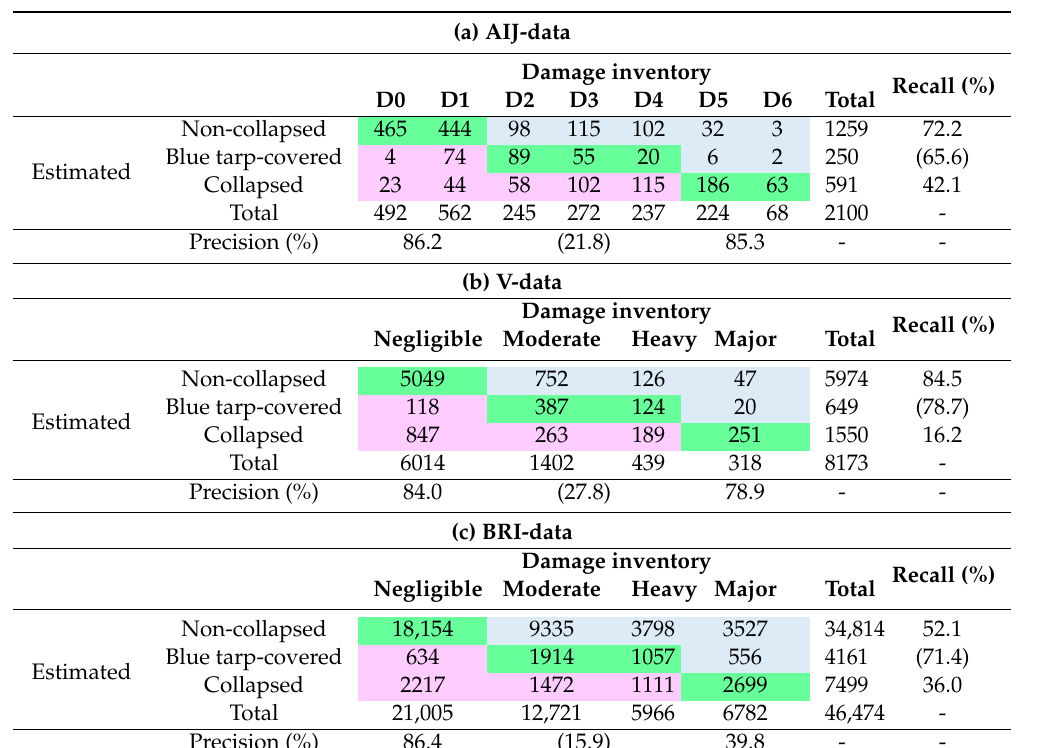
Table 7. Result of the CNN-based damage classification for each damage inventory. The colors of the cells indicate the labels of the classification; correctly estimated (light green), underestimated (light blue) and overestimated (pink). Accuracies for the blue tarp-covered buildings are shown by brackets since the blue tarp does not perfectly correspond to D2–D4 / moderate, heavy damage